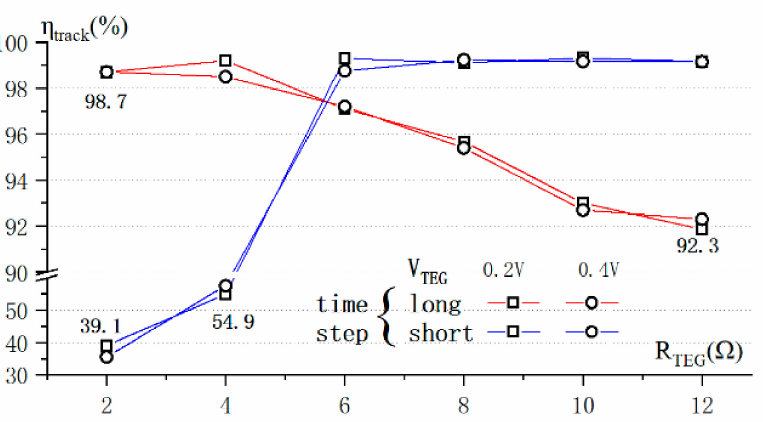
Figure 13. Tracking efficiencies of the compared MPPT circuit with a fixed-time step P&O